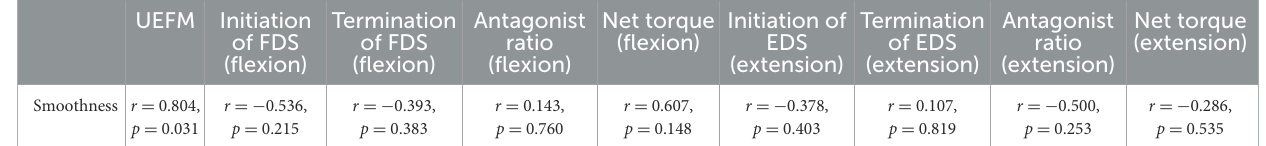
TABLE 2 Results (Spearman’s rank correlation coefficient and p -value) of correlation analysis of the smoothness of MCP joint movement with the total UEFM scores, delays in initiation and termination, antagonist muscle ratio, and net torque, during voluntary flexion and extension,